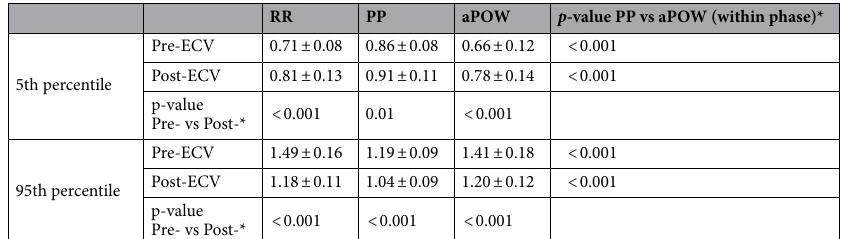
RR PP aPOW p -value PP vs aPOW (within